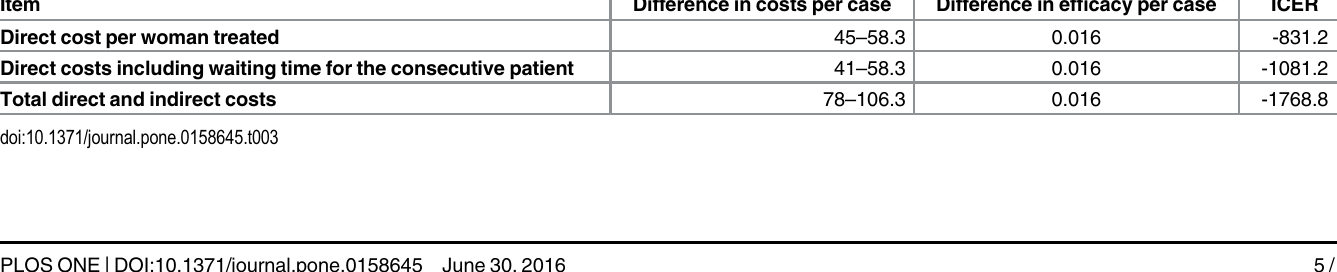
Table 3. Incremental cost effectiveness ((ICER) of different measures of costs, EUR.